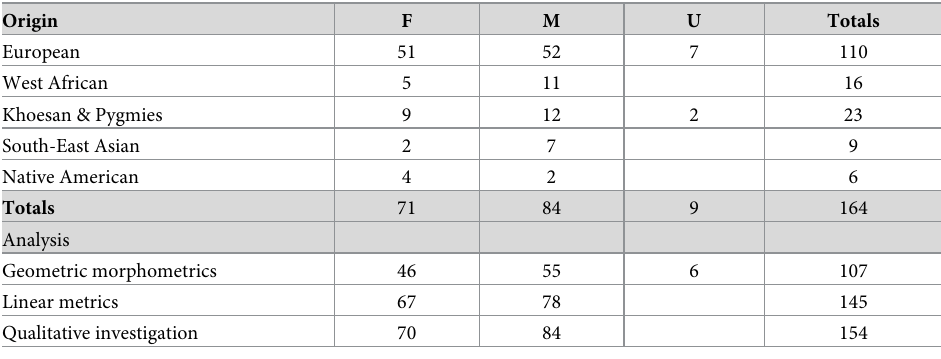
Table 2. Sample composition by origin and by